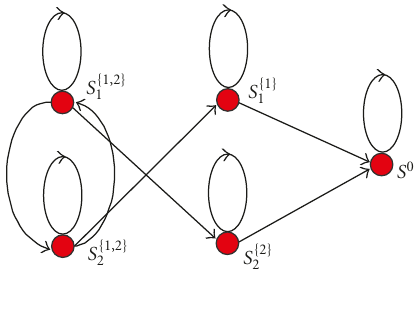
Figure 3: Illustration of state transitions when M = 2.